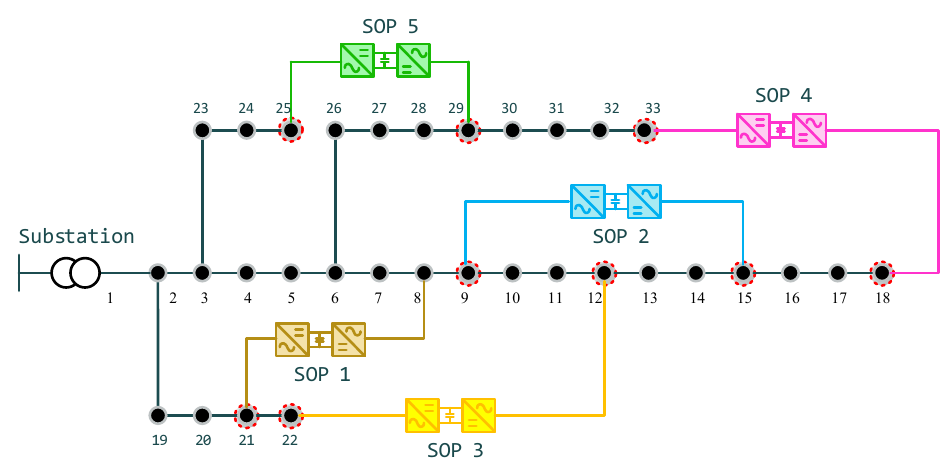
Figure 7. SLD of the modified IEEE 33 bus system with five SOPs.